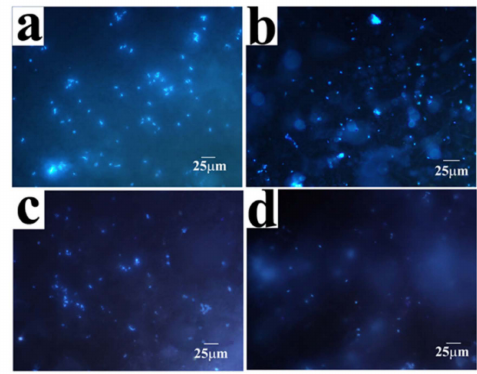
Figure 8. Fluorescence microscopy images of ( a ) A 0 , ( b ) A CS1 , ( c ) A CS2 , and ( d ) A CS3 after 24 h of exposure in PBS medium suspended with 10 6 cfu mL − 1 E.